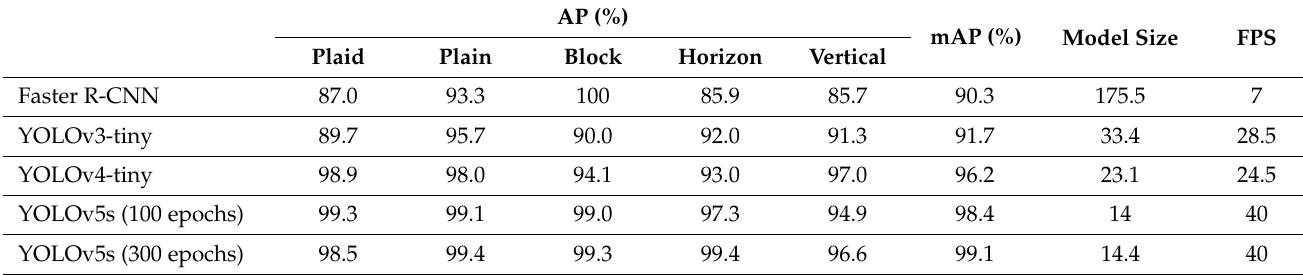
Figure 15. Integration results of YOLOv5s (100 epochs).